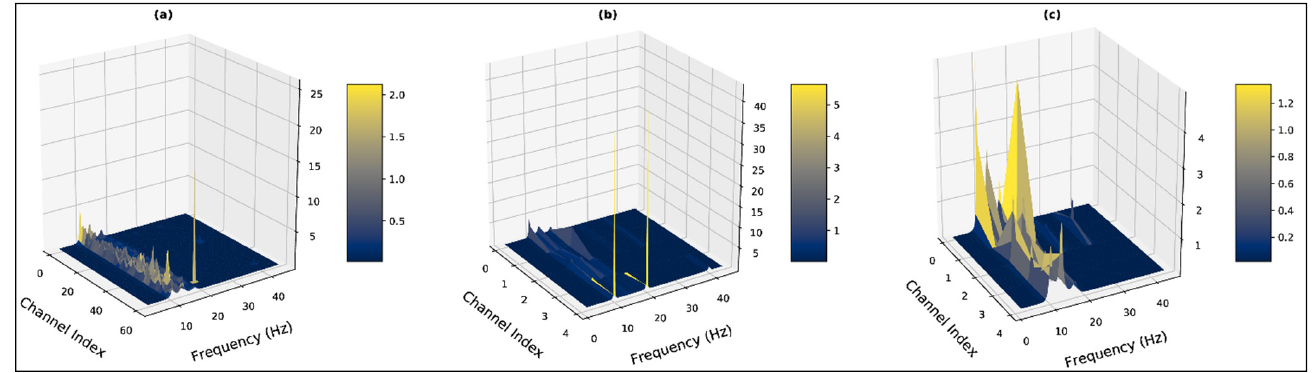
Figure 8. Three-dimensional visualization of the computed MUSIC spectrums for subject: 1, state: negative, trial: 5 ( a ) considering all 62 channels ( b )reducing the number of channels ( c ) excluding the corrupt channels before channel reduction.